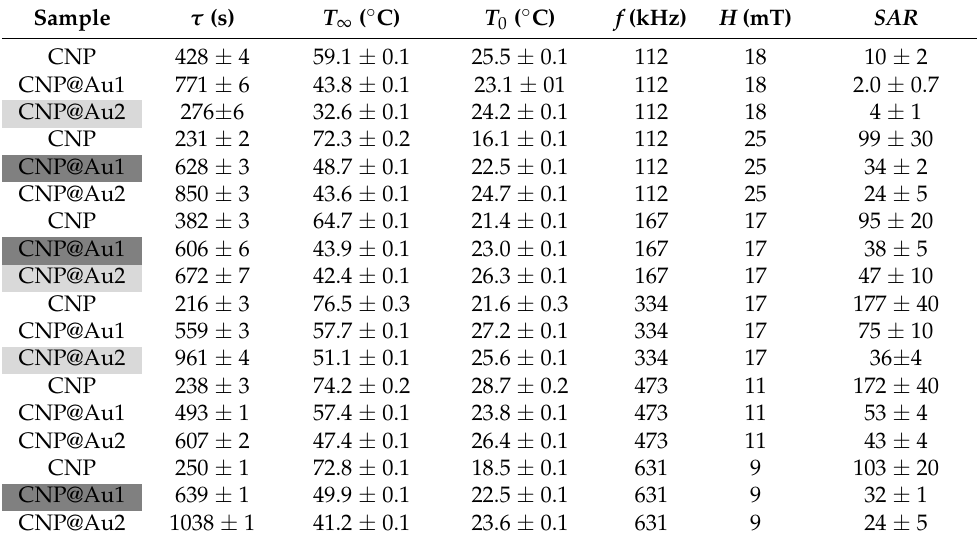
Table 2. The parameters ( τ , T ∞ and T 0 ) that were extracted from the fitting of the T versus t data (e.g., see Figure 4) at a fixed combination of the frequency ( f ) and amplitude ( H ) of the AC magnetic field. The estimated SAR values (in kW/kg-Fe) are included in last